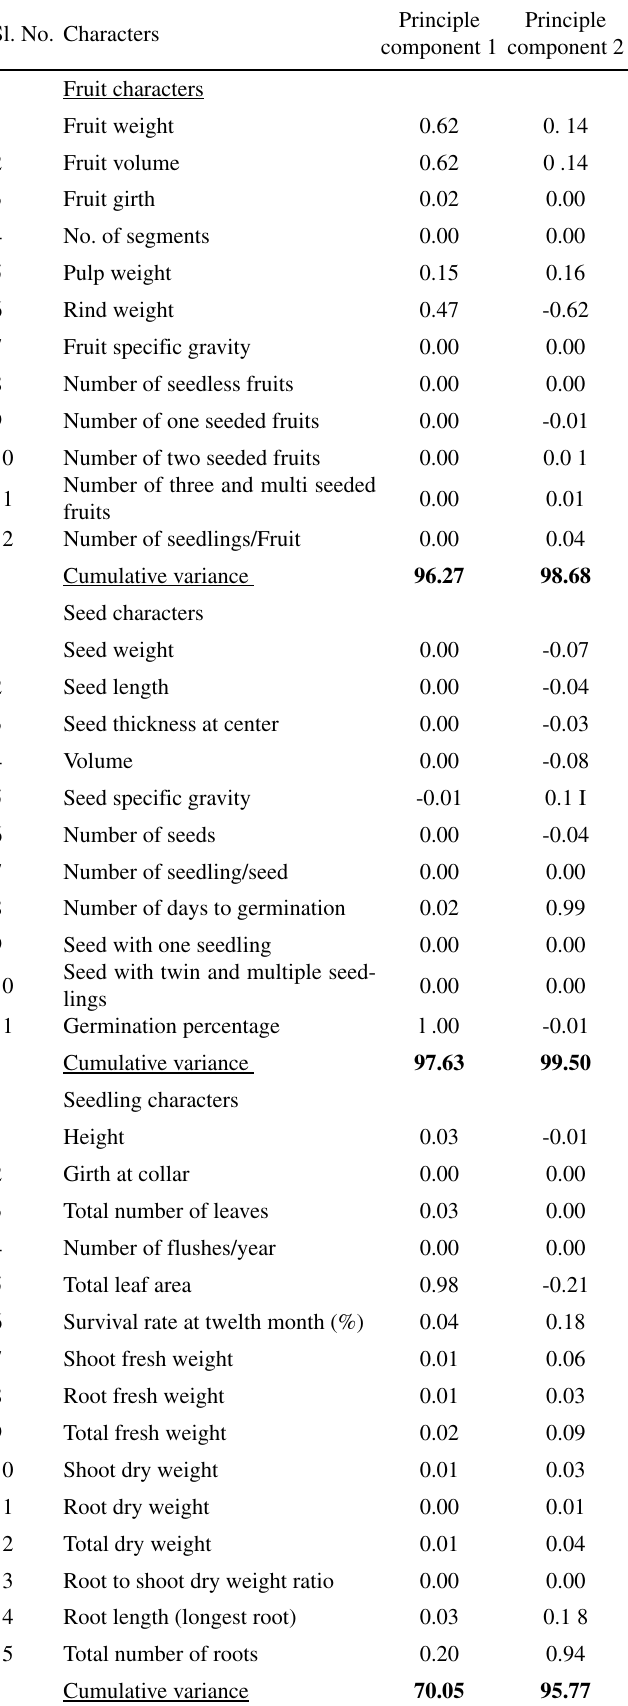
Table 1 - Latent vectors and variance of the principal component analy- sis performed for generating fruit, seed and seedling indices separately in mangosteen ( Garcinia mangostana L.)